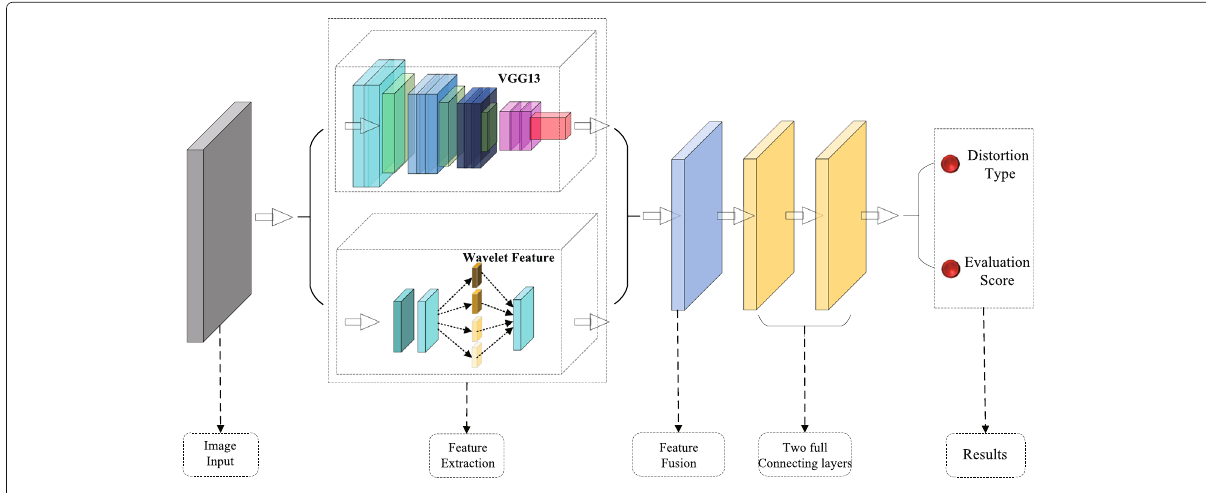
Fig. 2 Framework of the proposed EI-IQA